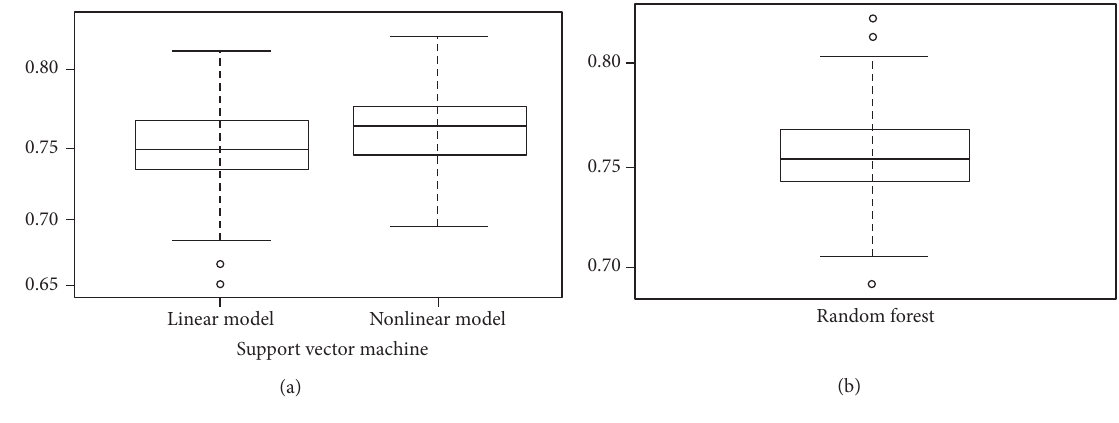
Figure 7: Classification accuracy of SVM and random forest.